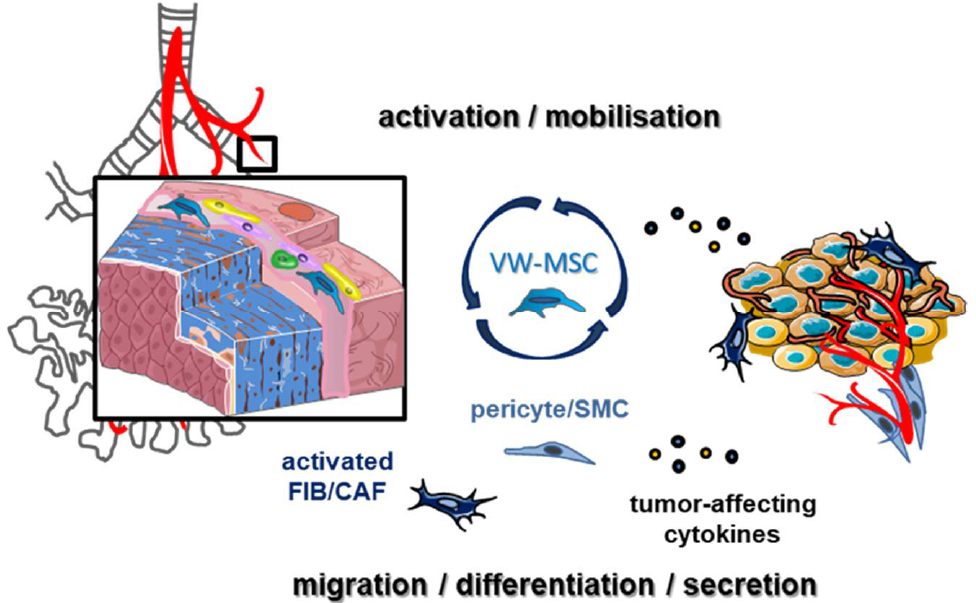
Figure 1. Lung-resident mesenchymal stem cells (LR-MSCs) potentially impact on lung cancer. LR-MSCs, predominately residing within the vasculogenic zone of adult lung arteries, are important orchestrators of normal lung homeostasis. Within this vascular stem cell niche also endothelial progenitor cells (displayed as yellow cells) and hematopoietic stem cells (green cells) reside. Following a pathological trigger, LR-MSCs seem not to appear sufficient to prevent lung tissue destructions and subsequent remodeling processes. LR-MSCs might at least partially contribute to lung diseases, particularly to lung cancer. Adjacent tumor cells (brown cells), tumor-derived factors, as well as associated hypoxia and inflammation might induce LR-MSCs mobilization and/or activation. Cancer-educated LR-MSCs in term contribute to the formation of malignant microenvironments fostering cancer progression and potentially therapy resistance by (i) differentiating into pericytes and smooth muscle cells (SMC) and, thus, impacting on vascular remodeling of newly formed tumor blood vessels, (ii) acquiring an activated fibroblast (myofibroblast or cancer associated-fibroblast, CAF) phenotype, and (iii) an altered tumor-promoting LR-MSC secretory profile engaging bi-directional intercellular interactions within lung tumors. Finally, although preclinical evidence is lacking up to now, LR-MSCs could be a cell of origin for lung cancer development or initiation. A detailed understanding of how LR-MSCs are implicated within the tumor stroma, and, thus, critically contribute to the heterogeneity and complexity of lung cancer biology, could foster strategies to manipulate these cells on site, finally paving an additional way for the discovery of potential drug targets for NSCLC patients. However, the role of endogenous LR-MSCs to function as tumor-stromal